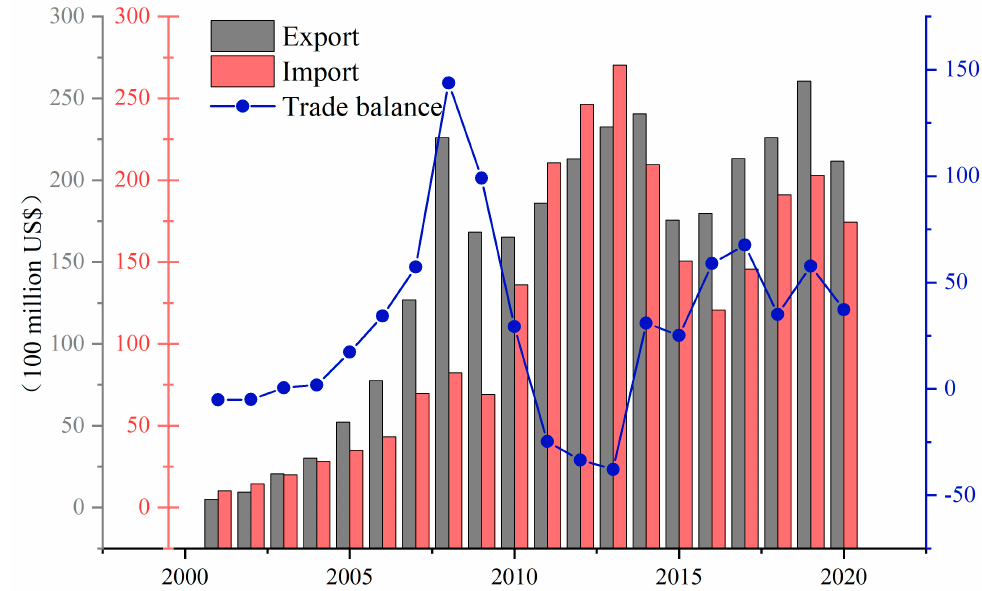
Figure 3. Changes in trade with China in the CANs from 2001 to 2020. Table 3. CANs trade imports and exports from 2001 to 2020 (US$100 million). Period Total Export Volume Import Volume Trade Balance Before